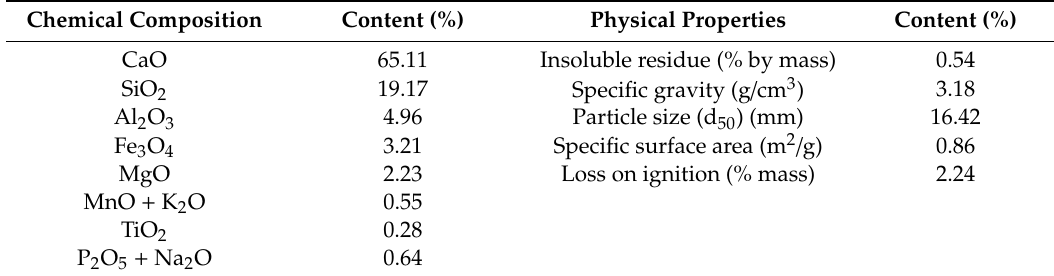
Table 1. Properties of ordinary Portland cement (OPC).